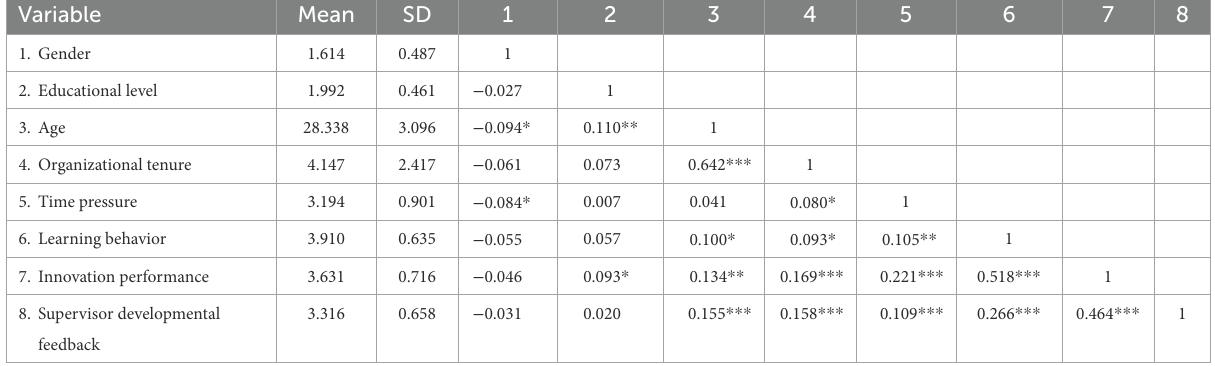
TABLE 5 Mean value, standard deviation, and correlation coefficient of variables in Study 2.